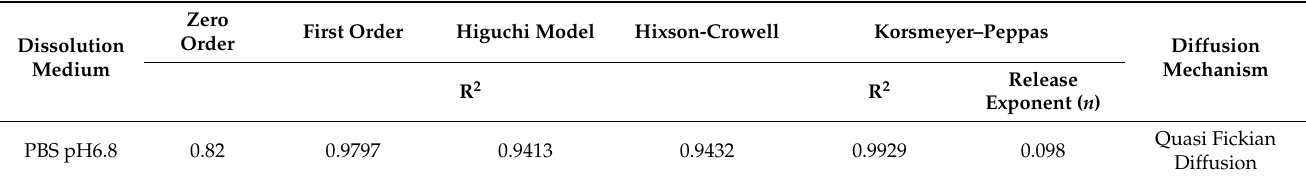
Table 8. Kinetic profiles of in vitro drug release of optimized PRX NS (NS9).